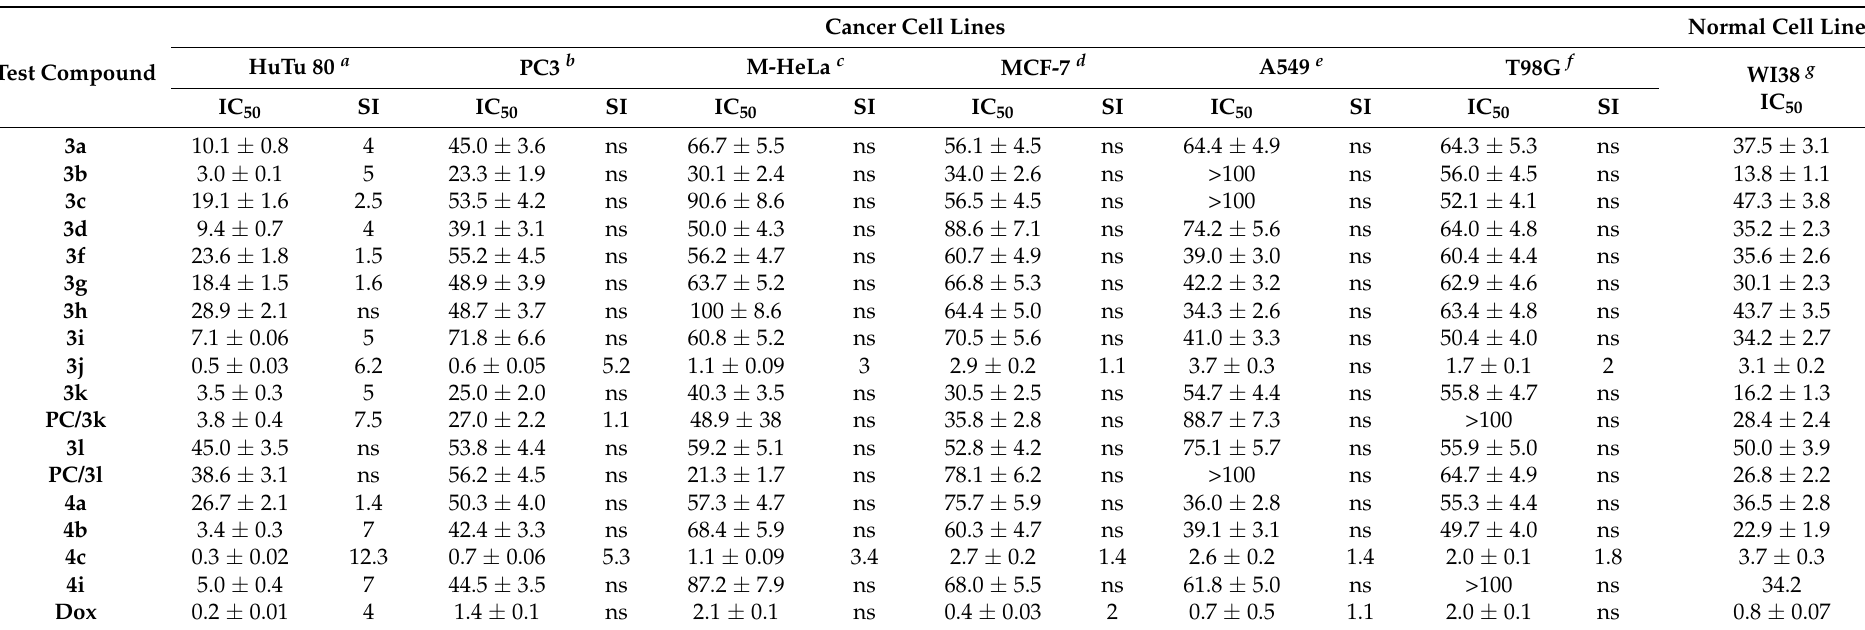
Table 2. In vitro cytotoxicity ( µ M) of 2-hydroxypropylphosphonium salts against human cancer and human normal cell lines and selectivity index values (SI) of lead